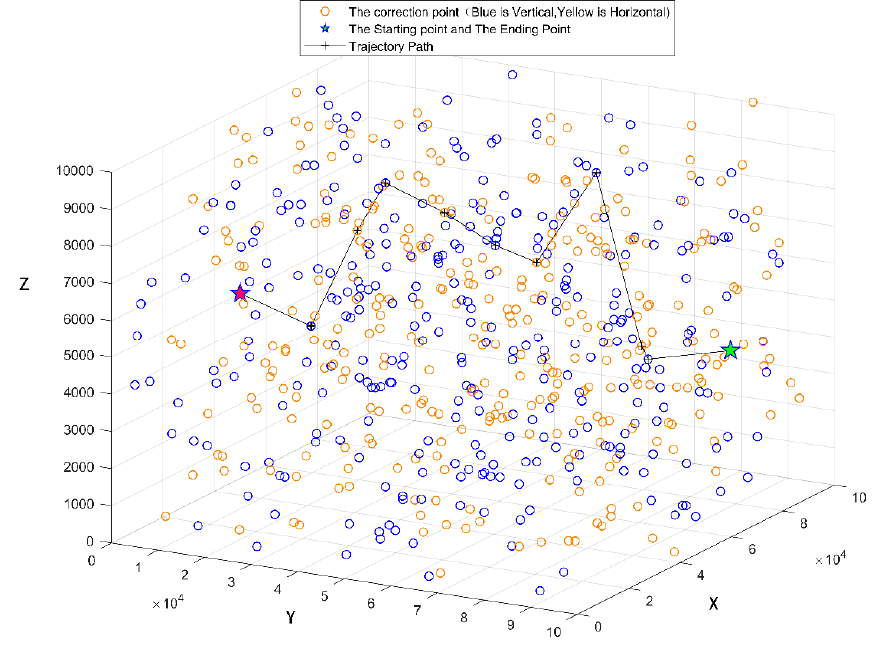
Figure 9. Trajectory planning path for the Problem 1.